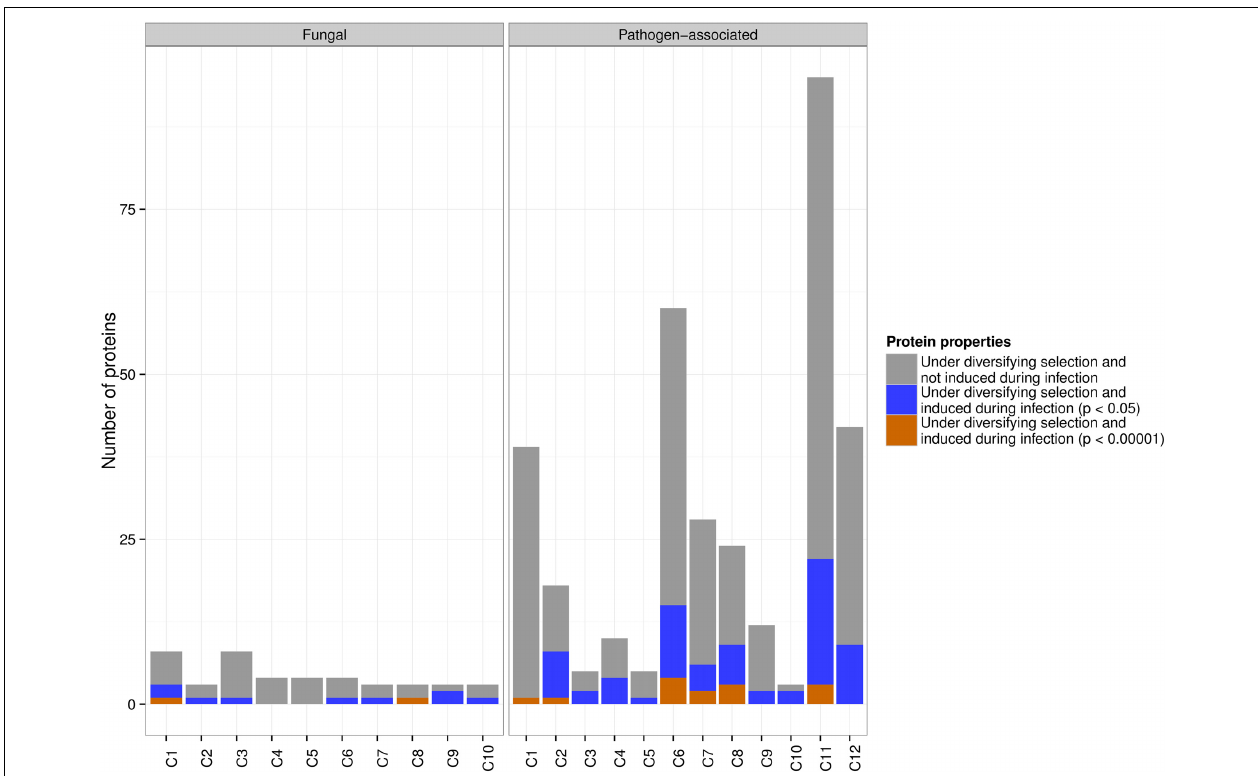
FIGURE 4 | The distribution of pathogen-associated and fungal genes with in planta up-regulation and diversifying selection across the clusters. Diversifying selection is predominantly predicted for genes that are part of pathogen-associated gene families. At a significance threshold of